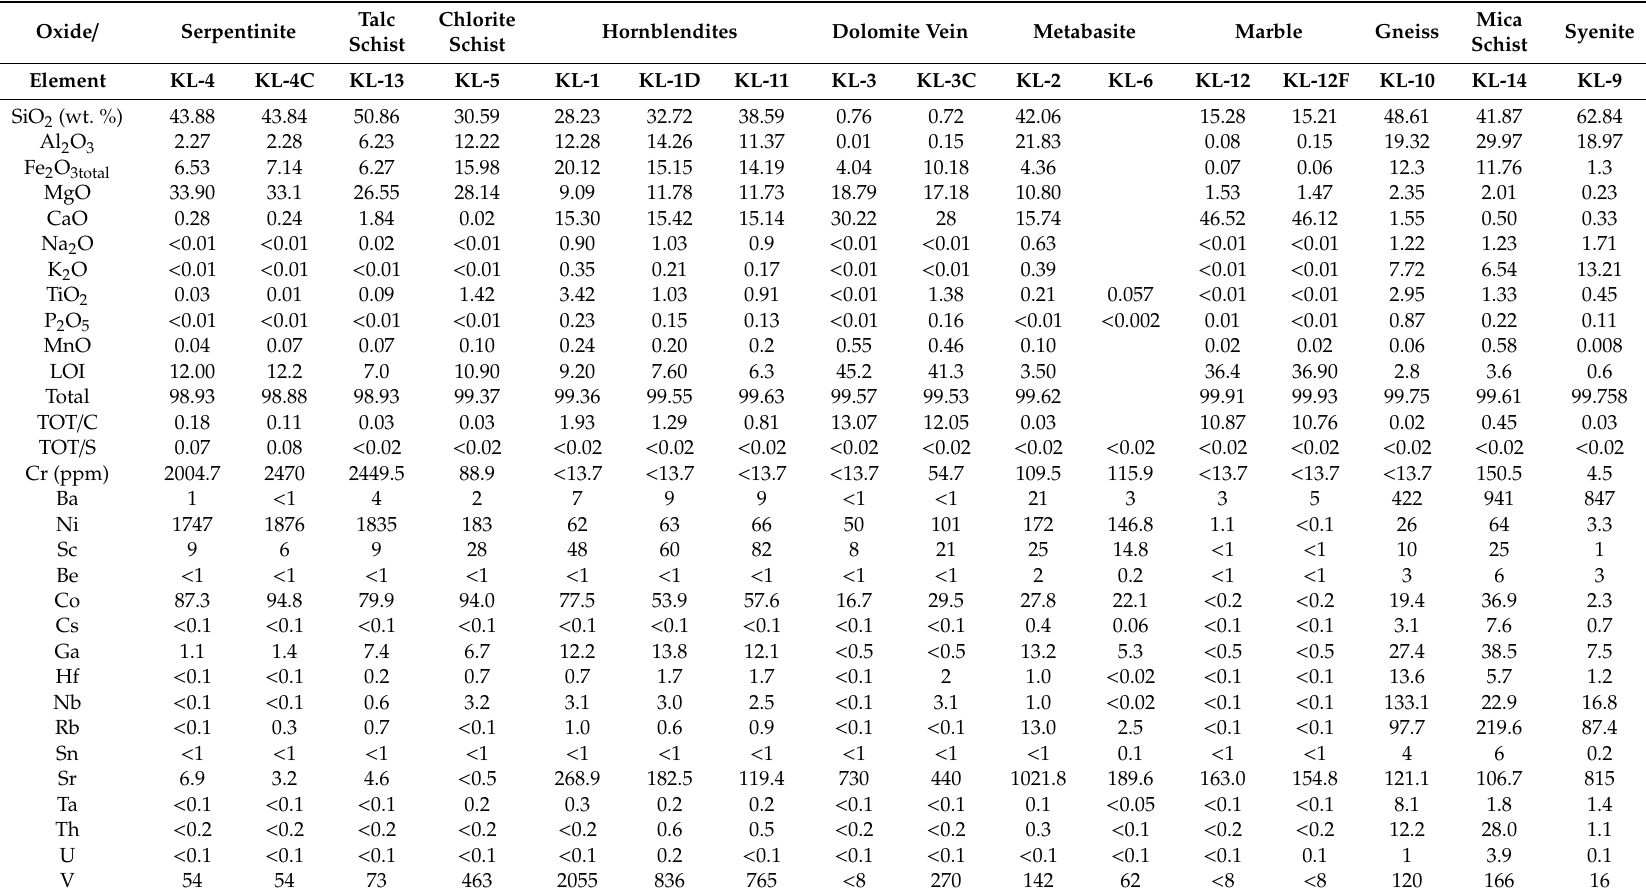
Table 2. The bulk-rock chemical composition of studied rocks from Kletno in the ´Snie˙znik